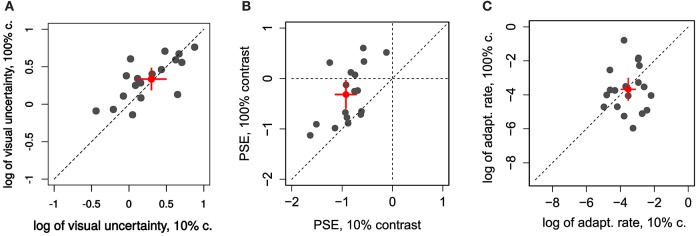
Individual comparison of 10% and 100% contrast conditions in Experiment 1 for: (A) the log of visual uncertainty (log of  JND∕2) (B) PSE and (C) log of adaptation rate. Red dots and error bars represent averages and 95% confidence intervals.